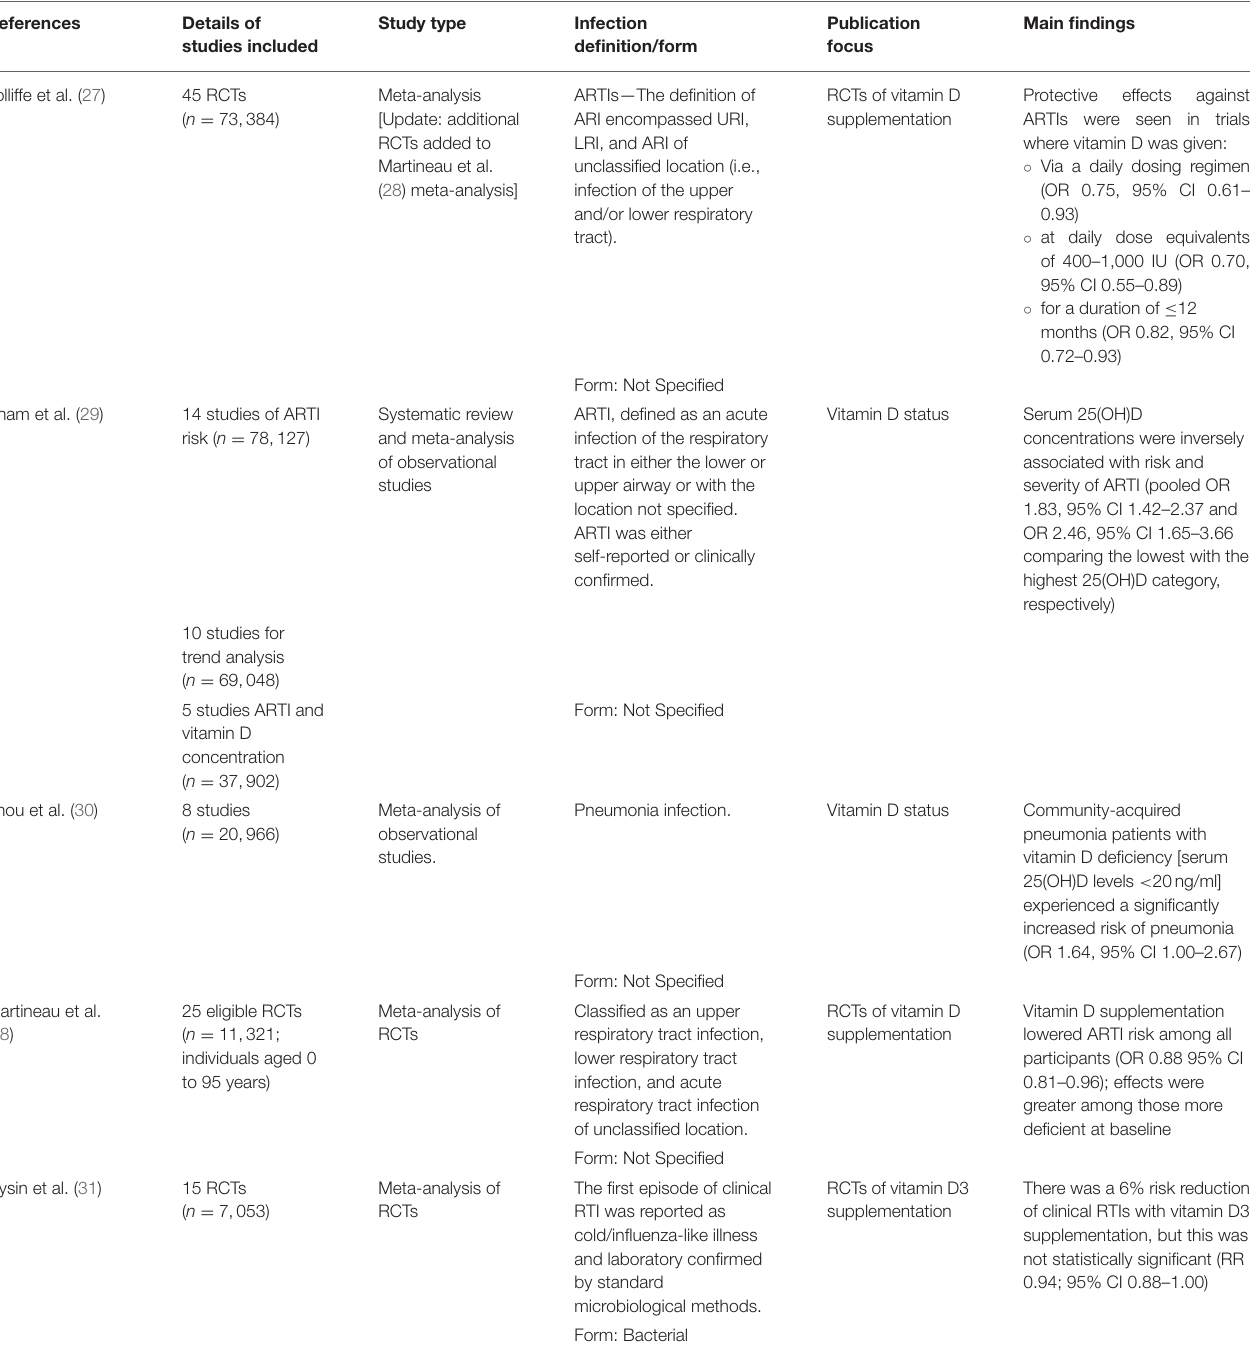
TABLE 1 | Summary of meta-analyses of vitamin D and RTIs with a focus on adults.